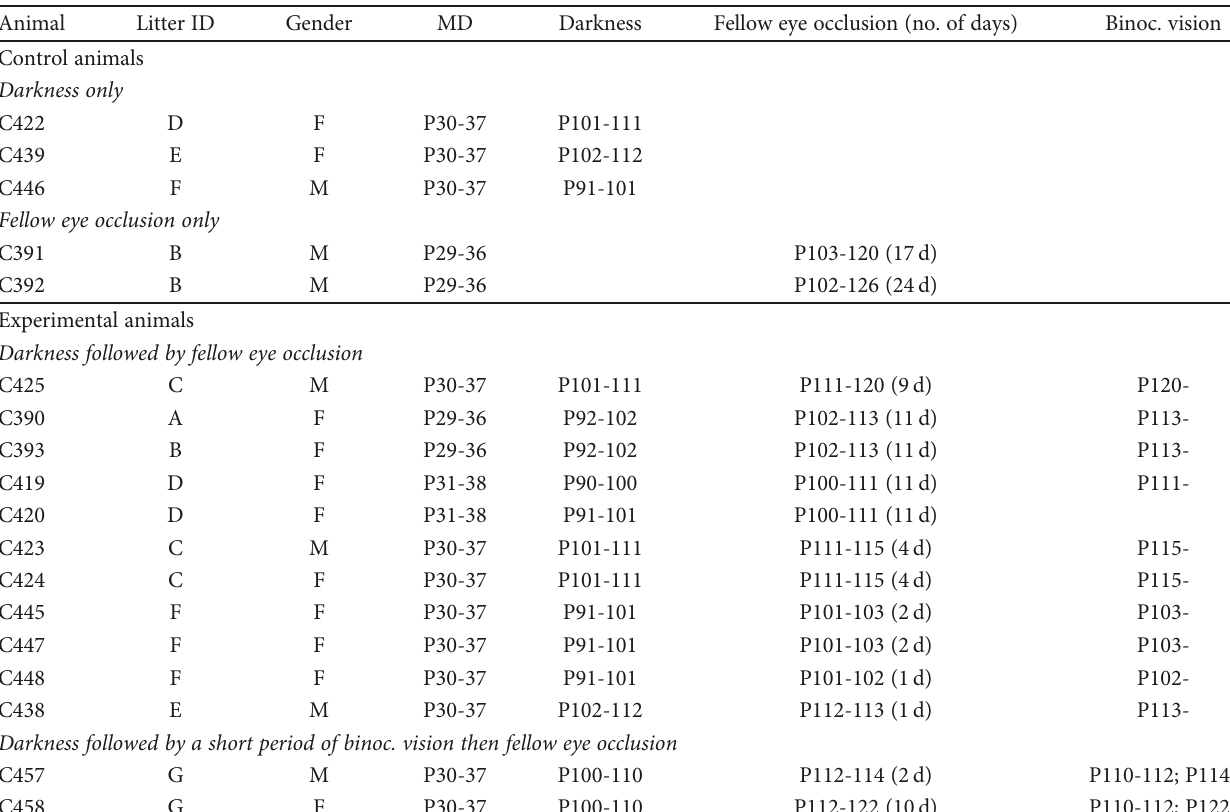
Table 1: Animals and rearing conditions. Timing (postnatal days of age) of the initial period of monocular deprivation (MD), darkness, and subsequent visual exposure (fellow eye occlusion and/or binocular vision) for all 18 kittens. Details are also provided on the 6 litters and the gender of the kittens. Prior to and for the 8+ weeks following the period of MD, all kittens received binocular visual exposure. Animal Litter